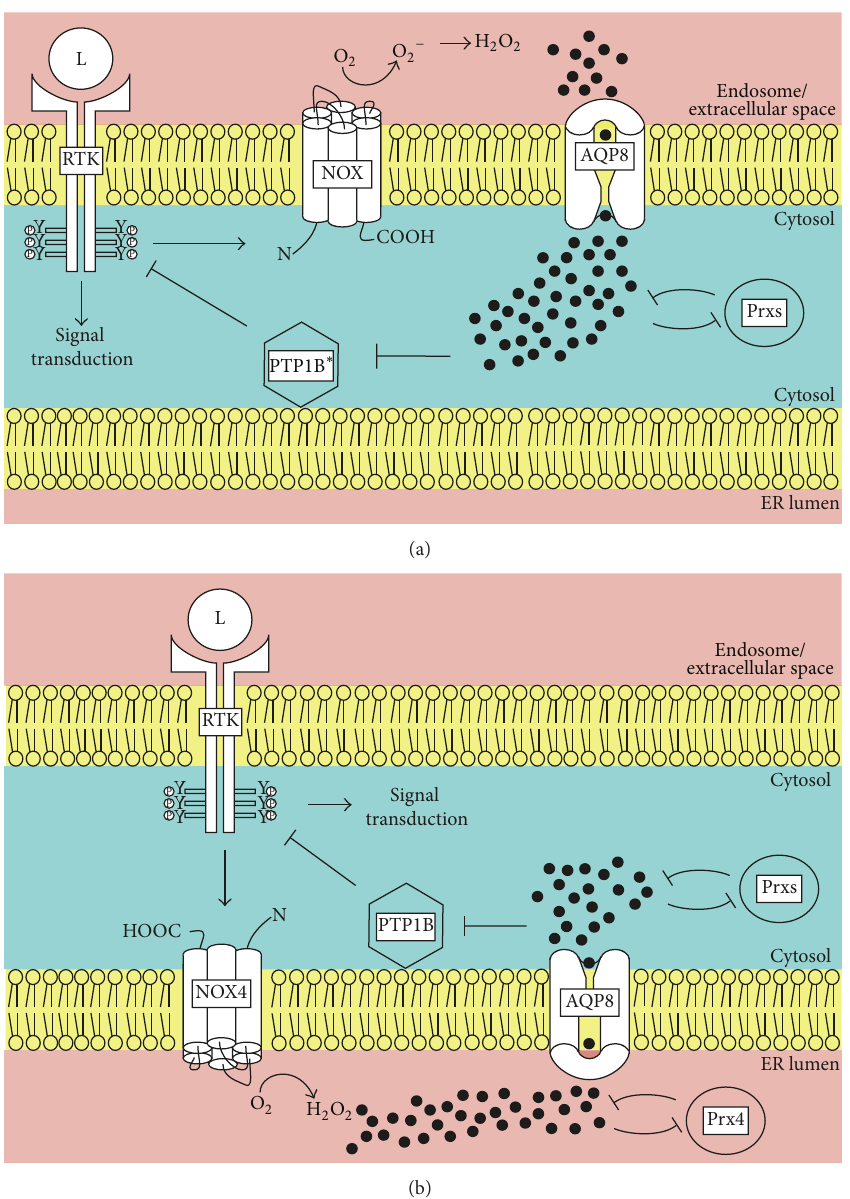
Figure 1: RTK signaling involves NOX-derived H 2 O 2 as second messenger. (a) Binding of ligand (L) to receptor tyrosine kinases (RTK) on the cell surface activates NADPH oxidases (NOX) and leads to the generation of extracellular or, following endocytosis, endosomal superoxide (O 2− ), which can be dismutated to H 2 O 2 (black filled circles). Upon aquaporin 8 (AQP8)-facilitated diffusion across the plasma/endosomal membrane, H 2 O 2 locally inactivates the intracellular negative regulators phosphotyrosine phosphatases (PTPs) and peroxiredoxins (Prxs), which prolongs RTK signal transduction. This step mostly, but not exclusively (as depicted by an asterisk), involves the endoplasmic reticulum (ER)-associated PTP1B. Spatial restriction of H 2 O 2 is achieved by cytosolic ROS scavengers like Prxs. (b) An ER-centered route of RTK- mediated signal transduction involves NOX4 in the ER membrane and PTP1B. In this context, ER-luminal buildup of H 2 O 2 is controlled by ER-resident